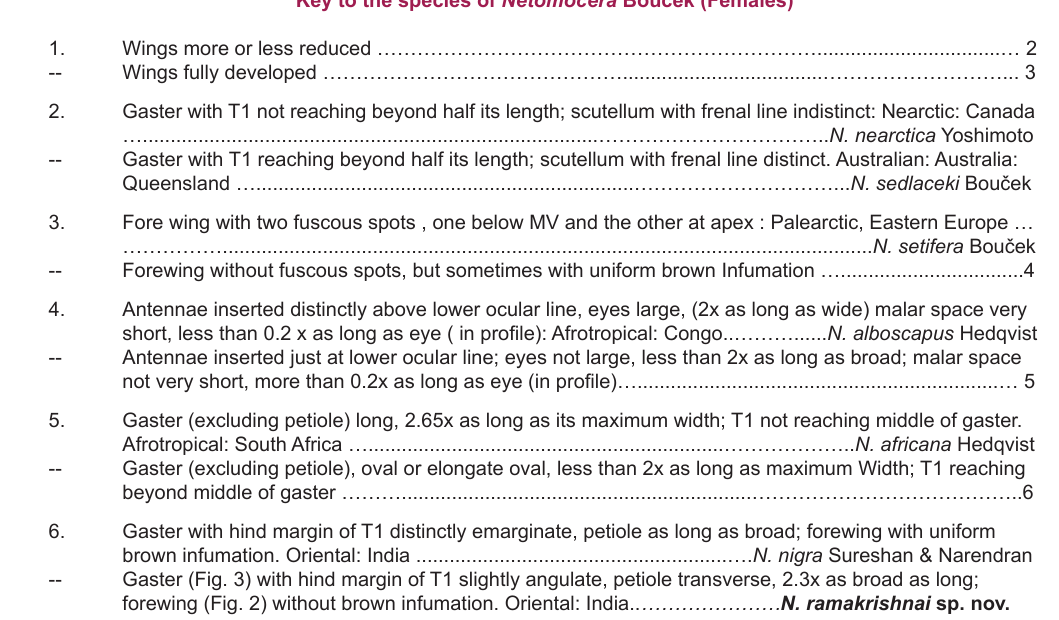
coxa 22, femur 31, tibia 32, tarsus 24, basitarsus 2x as long as second segment. Forewing (Fig. 2) 2.2x as long as broad, pubescence almost complete, dense, except for a narrow elongated speculum which is shiny, marginal fringe present only in the lower margin, veins with a row of strong brown bristles which is in double row on MV, a line of long white hairs below MV on ventral surface, basal cell completely hairy, costal cell 11x as long as broad, hairy in the upper half of ventral surface which is complete at tip. Relative lengths of SMV 35, MV 25, STV 7, PMV 13 Gaster: (Fig. 3) elongate ovate, 1.8x as long as broad in dorsal view (excluding petiole) and as long as head and thorax combined.(including petiole); petiole transverse, 2.3x as broad as long, dorsally with strong longitudinal ridges inside of which is irregularly relticulate; T1 covering most of the gaster, 1.3x as long as broad, posterior margins of T1 and T2 slightly angulate, other tergites reduced, with hind margins straight, ovipositor slightly protruded; hypopygium reaching end of T4. Male: Length 2.1mm. Differs from female in having short body which is completely black except for brown neck and lateral panel of pronotum. Legs except mid and hind coxae testaceous. Antennae (Fig. 4) with scape and pedicel testaceous remainder brownish-black, funicular segments elongated; antennal formula 11193; all funicular segments with numerous small sensillae and very small pubescence. Pubescence of lower face long; propodeum with median carina distinct; gaster short with petiole a little longer than broad with distinct longitudinal rugae; T1 covering most of the gaster, other tergites retracted; hind margin of T1 slightly emarginate; gaster including petiole 0.63x as long as head and thorax